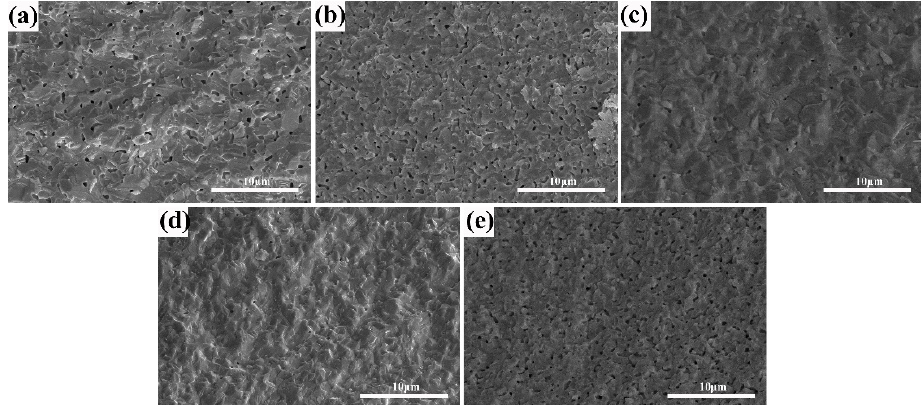
Figure 4. SEM photomicrographs of the fractured surfaces of the (Tb 0.7 Lu 0.3 ) 2 O 3 ceramics after 1500 °C hydrogen sintering with varying ZrO 2 contents: ( a ) 0 at%, ( b ) 2 at%, ( c ) 3 at%, ( d ) 4 at%, ( e ) 5 at%.